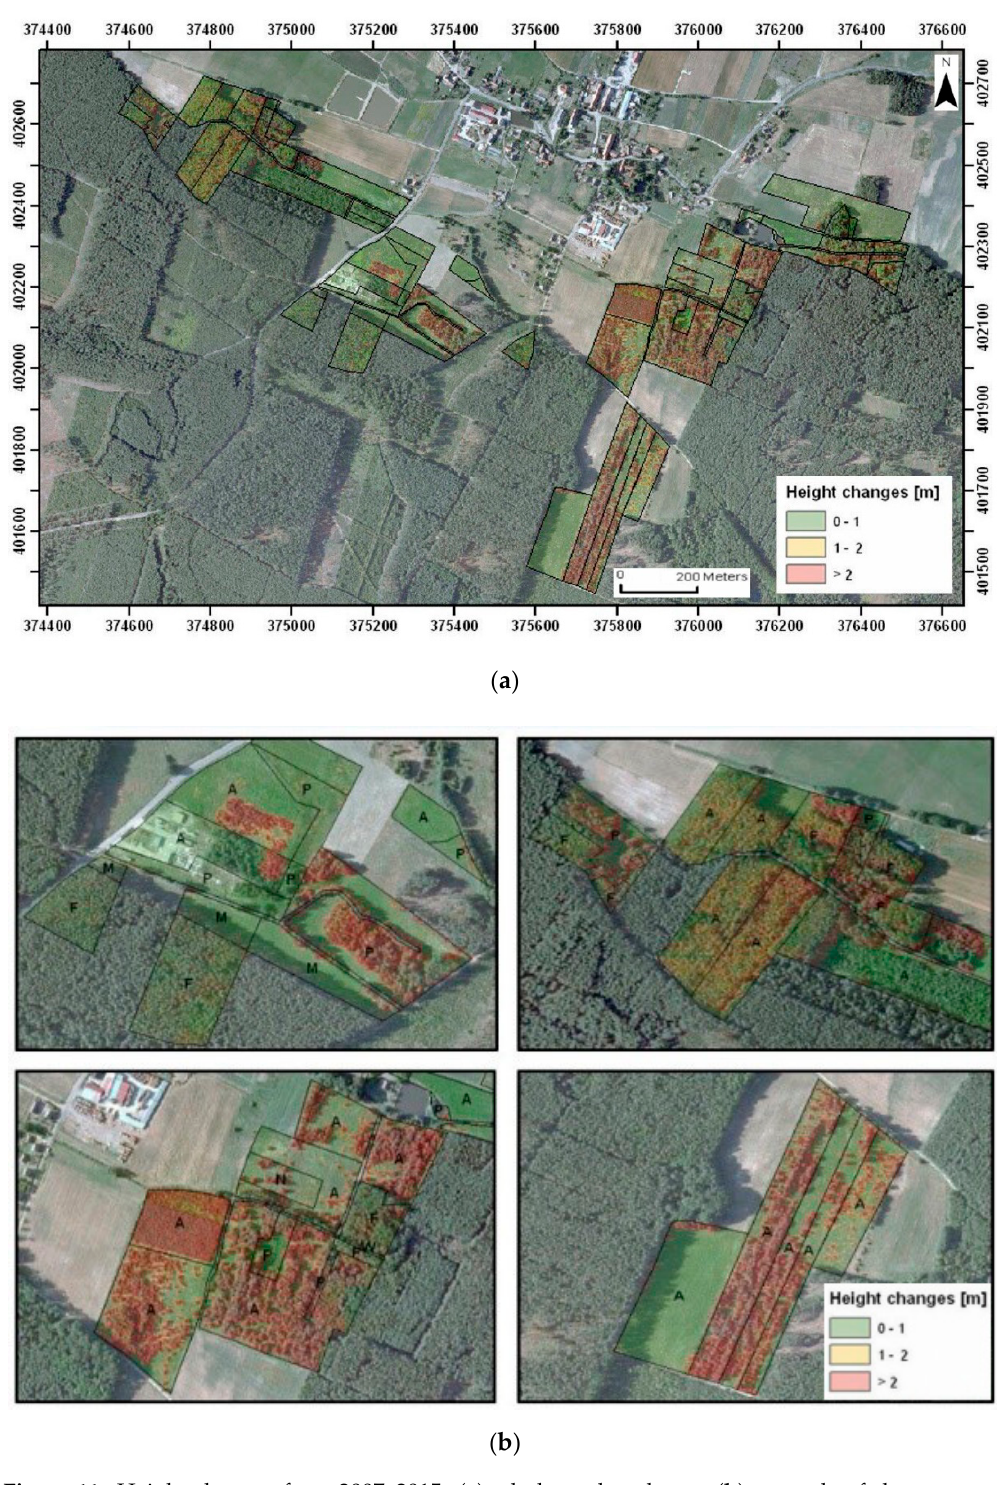
Figure 11. Height changes from 2007–2015: ( a ) whole analyzed area; ( b ) example of chosen parts. Background: orthophoto map and cadastral data (transparency in value: 60%). Background: orthophoto map and cadastral data (transparency in value: